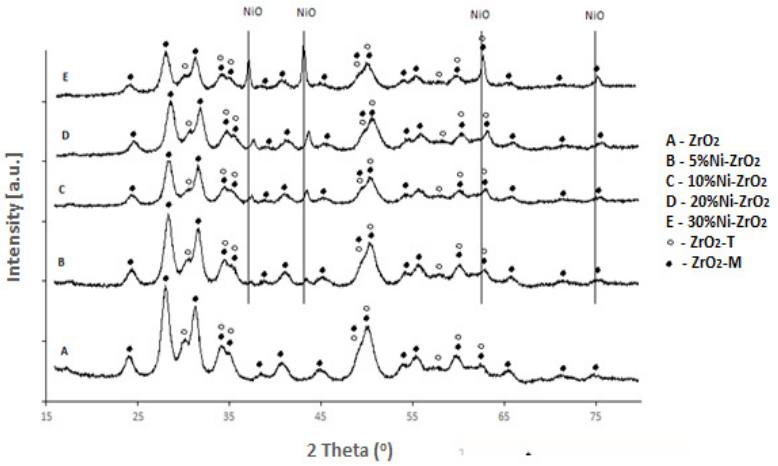
Figure 9. XRD curves of the ZrO 2 and monometallic Ni/ZrO 2 catalysts calcined in an air atmosphere for 4h at 400 °C.